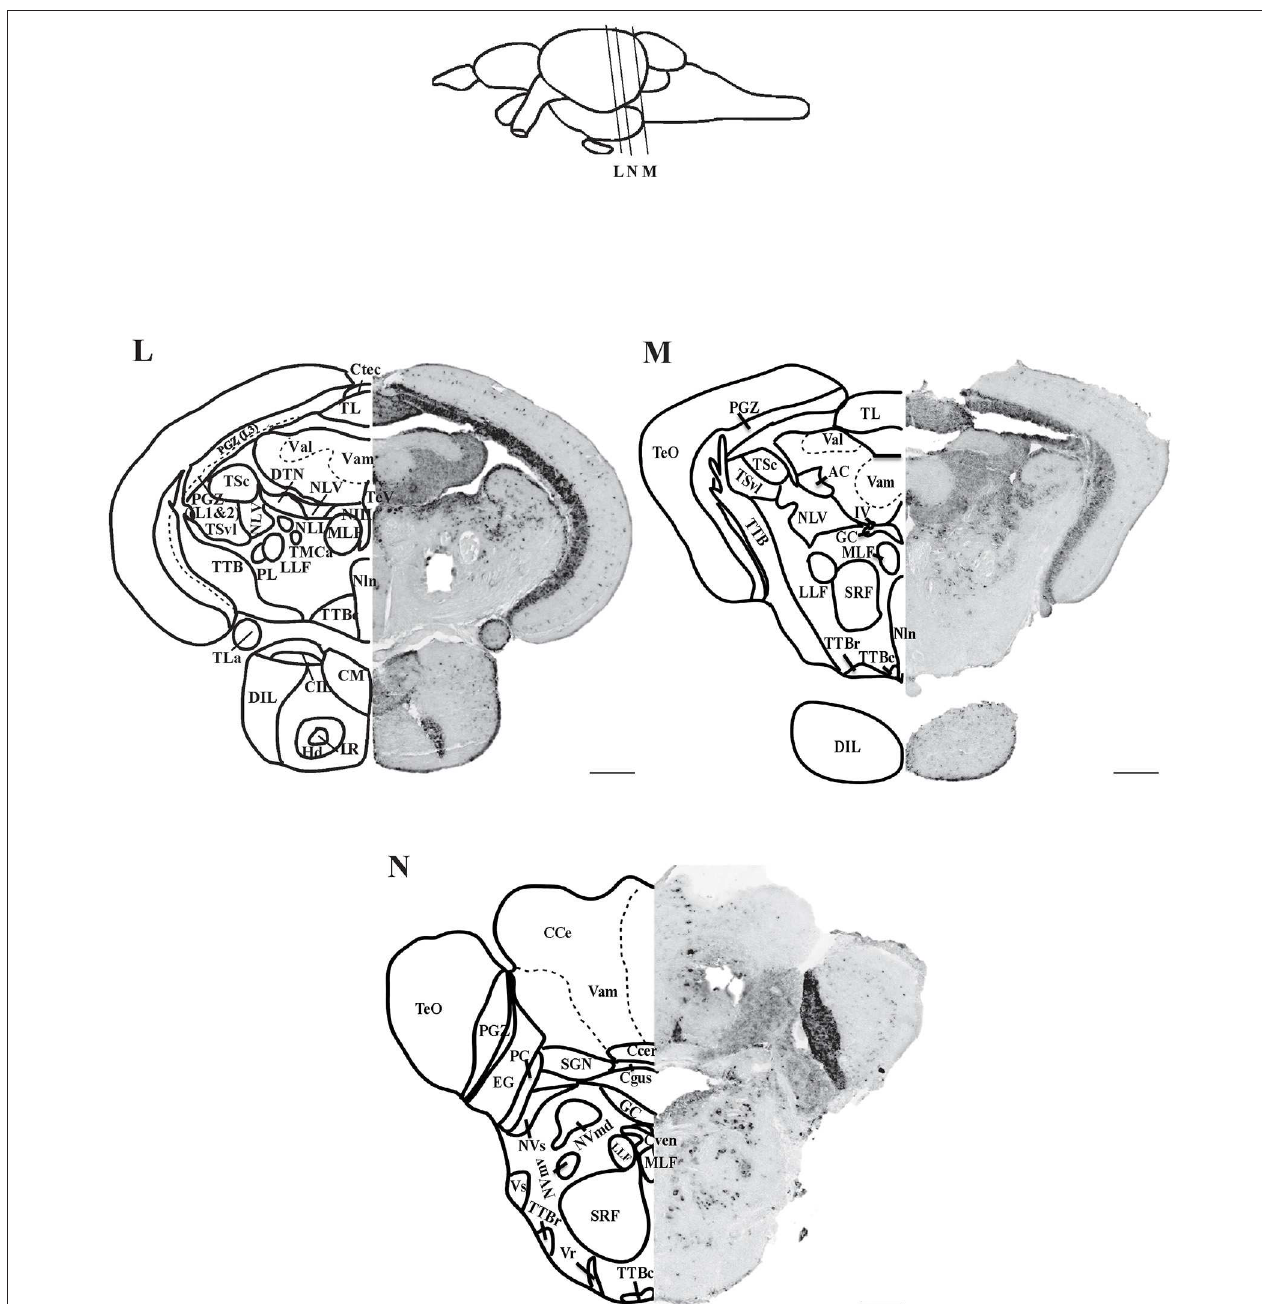
FIGURE 1 | Localization of oprm1 mRNA expression in the brain of zebrafish. Schematic coronal drawing of the brain of zebrafish showing the distribution of oprm1 mRNA expression. (A) Lines on a schematic sagittal drawing view of the zebrafish brain indicate levels of coronal sections, (B–N) coronal sections showing the distribution of oprm1 mRNA. n = 3, Scale bars: B–G (100 µ m) and H–N (200 µ m).